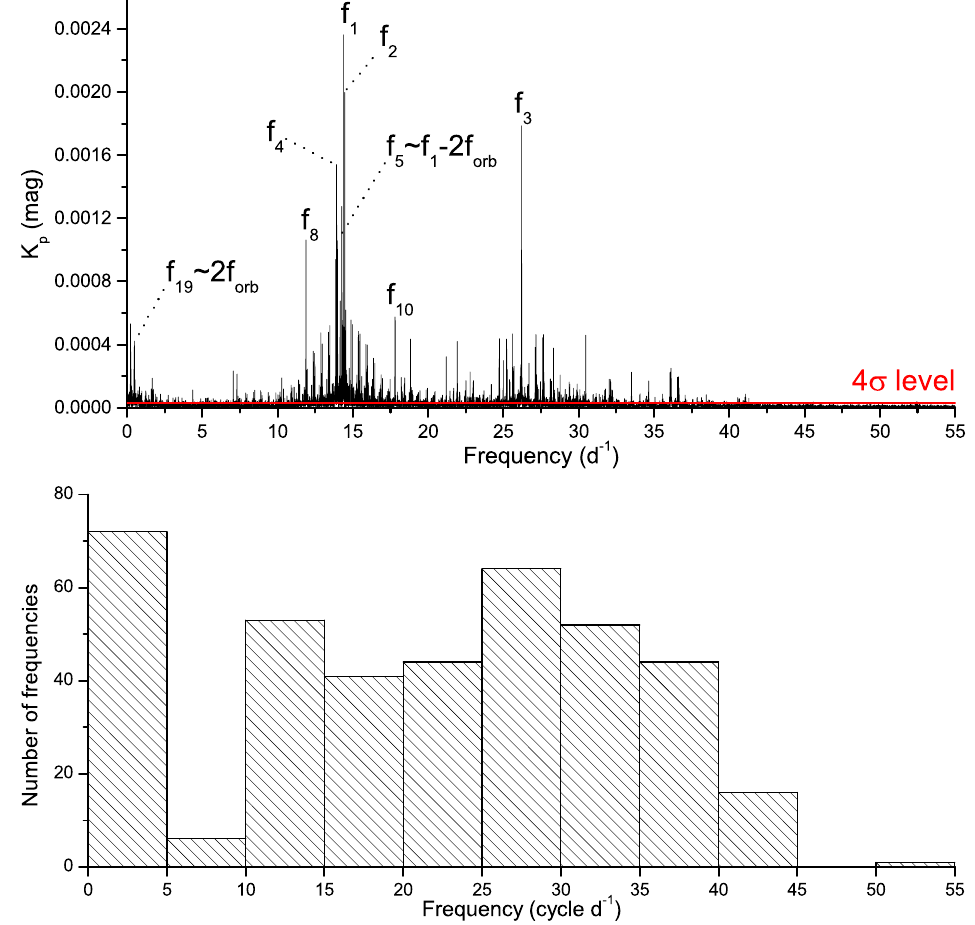
Figure 6. Periodogram ( top ) and frequency distribution ( bottom ) for KIC 8504570. The independent frequencies, the strong frequencies that are connected to the P orb and the significance level are also